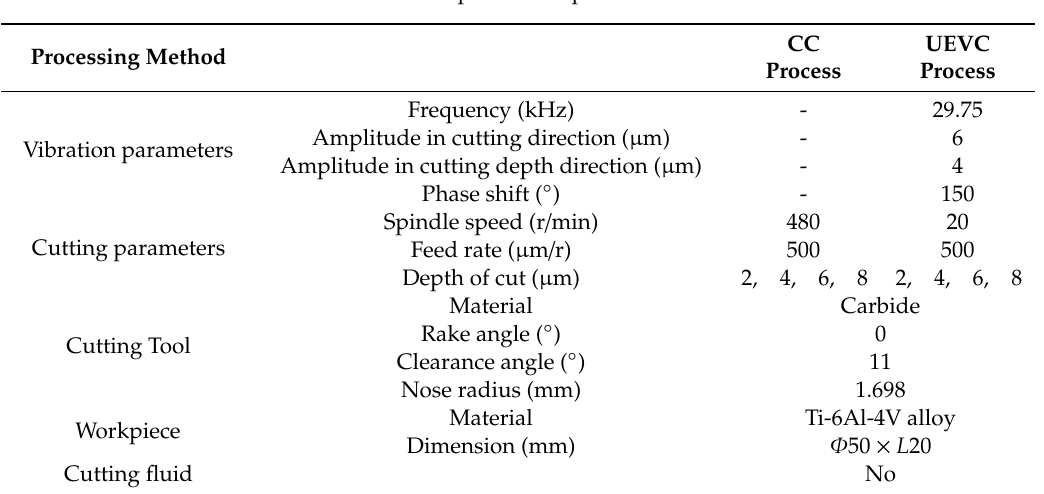
Table 2. Experimental parameters.